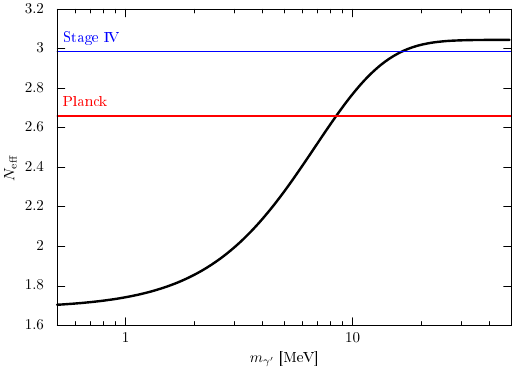
Figure 2 . The time evolution of (a): the energy density of the dark photon (cid:26) of photon and neutrino temperatures for the freeze-in scenario. Here we adopt m (cid:13) " = 10 (cid:0) 8 (red), 10 (cid:0) 9 (blue) and 10 (cid:0) 10 (green), respectively. For comparison we show the energy density of the dark photon in the thermal equilibrium (black). We solve the Boltzmann equation from temperature 300 MeV which is well above the neutrino decoupling temperature. The evolution of T (cid:13)e =T (cid:23) for " & 10 (cid:0) 8 is almost identical to the completely thermalized case. e